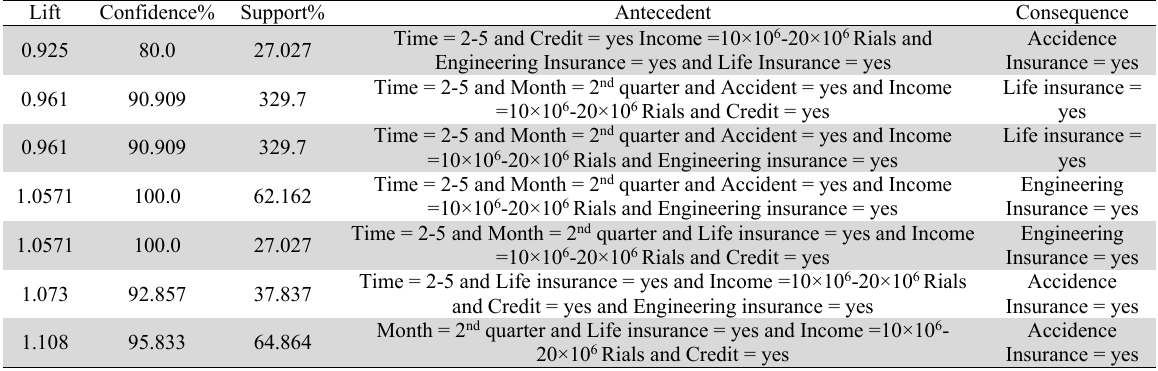
Examples of association rules in cluster